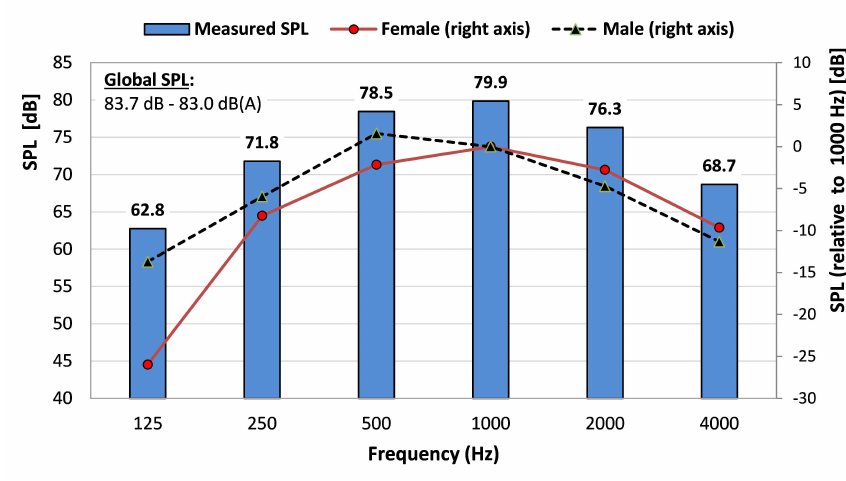
Figure 9: Mean sound pressure level at 1 m from small groups of people, as measured in Tindari street. The figure also shows the relative voice spectra for people speaking at loud voice level (adapted from reference